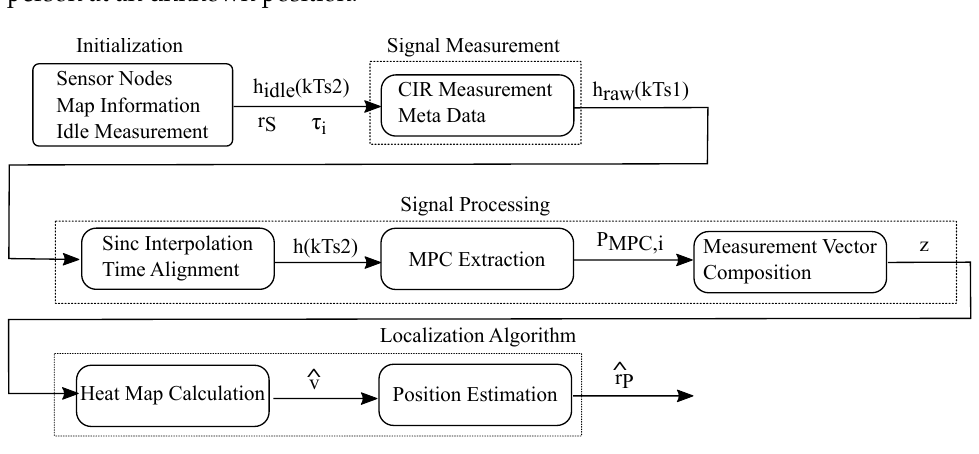
Figure 8. Block diagram of the localization